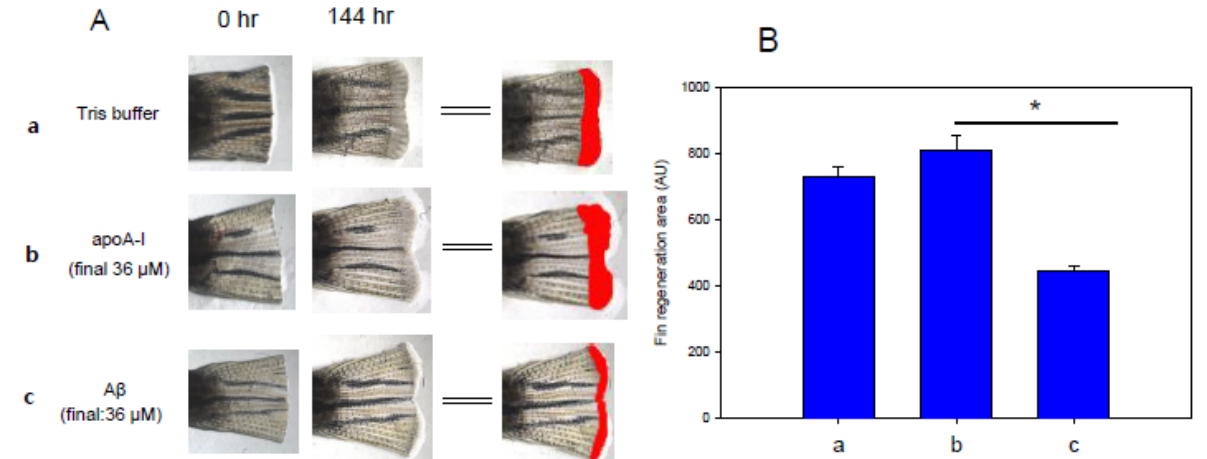
Figure 9. Comparison of tissue regeneration ability between apoA-I and A β . ( A ) Representative image of tail fin regeneration pattern at 144 h post-injection of apoA-I or A β (final 36 µ M). ( B ) Image analysis of fin regeneration area at 144 h after protein injection. The data are shown as the mean ± standard deviation (SD) of three independent experiments ( n = 7). *, p < 0.05 between apoA-I and A β .